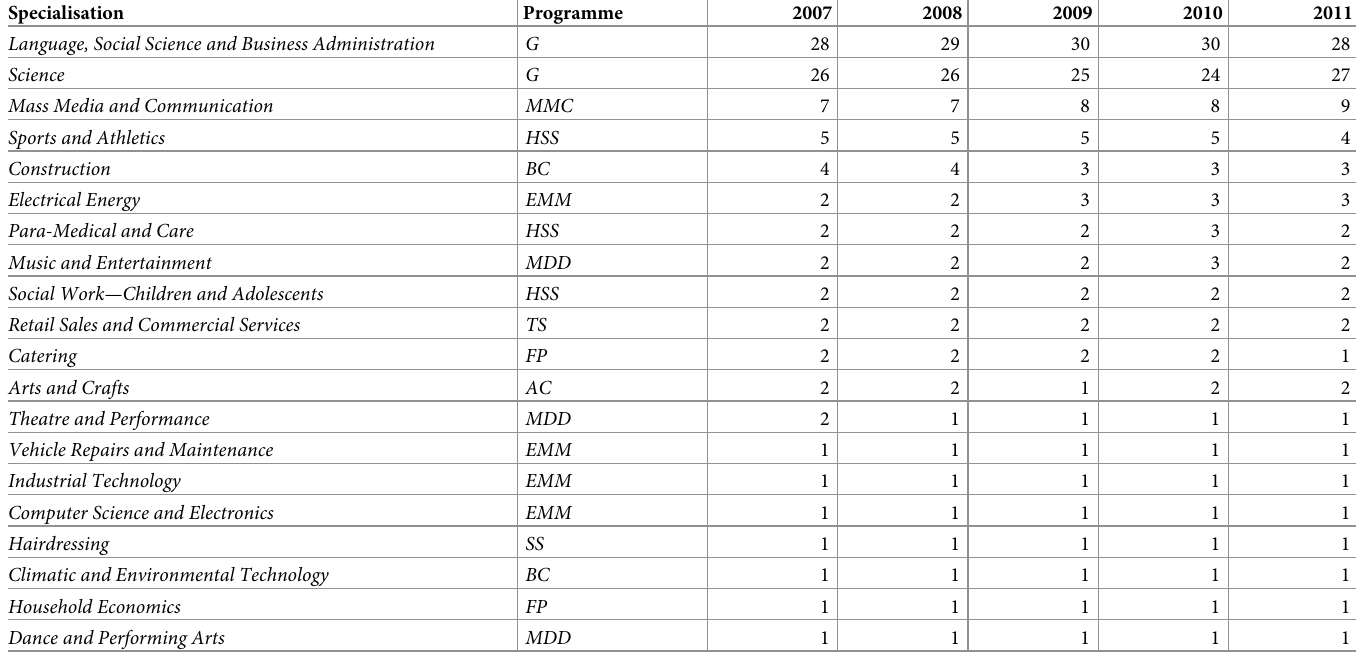
Table 2. Distribution of students over specialisation tracks. The twenty most popular specialisation tracks and their programme (abbreviated), with proportional share of students registered on each for each of the five years in our study. All figures are in percent, and include both natives and immigrants. Specialisation